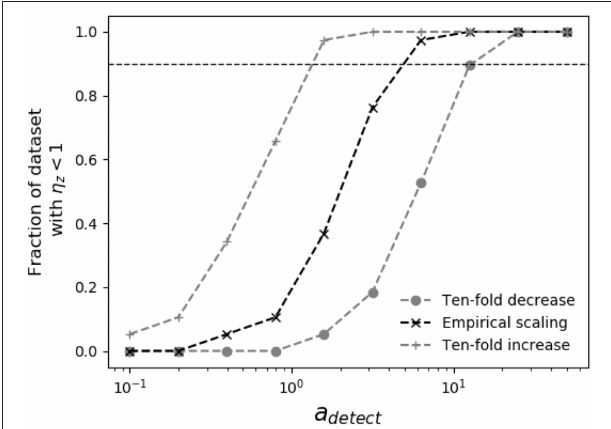
FIGURE 4 | Sensitivity of grazer capture efficiency to assumed predator detection area. Shown is the fraction of measured grazer maximal clearance rates, φ z that fall at or below the theoretical upper limit, ρ z (i.e., η z < 1), for various assumptions regarding predator swimming speed and detection area. The horizontal dashed line shows when 90% of the theoretical estimates of ρ z place upper bounds on φ z . Different assumptions about swimming speeds cover ranges reported in the literature ( Martens et al., 2015; Milo and Phillips, 2016), allowing 10-fold increase and decrease in the empirical scaling reported by Kiørboe (2011) ( Table 2 ). When swimming speed and body size are related by the empirical scaling reported by Kiørboe (2011), predator detection radius must be at least four times the predator radius ( a detect ≈ 4) for theoretical encounter kernels to place upper bounds on measured maximal clearance